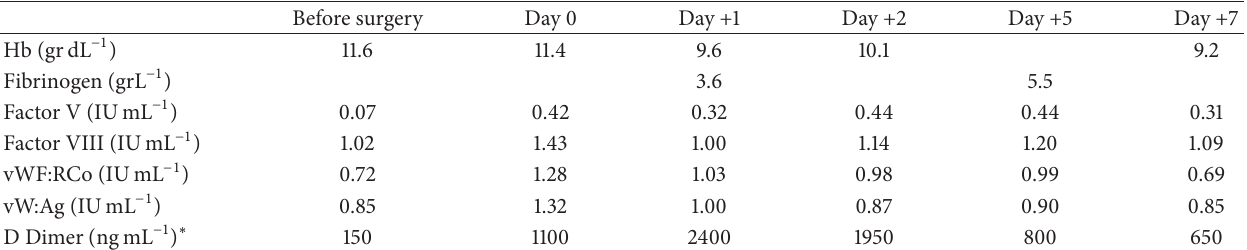
Table 1: Haemoglobin and haemostasis parameters before surgery and after surgery.